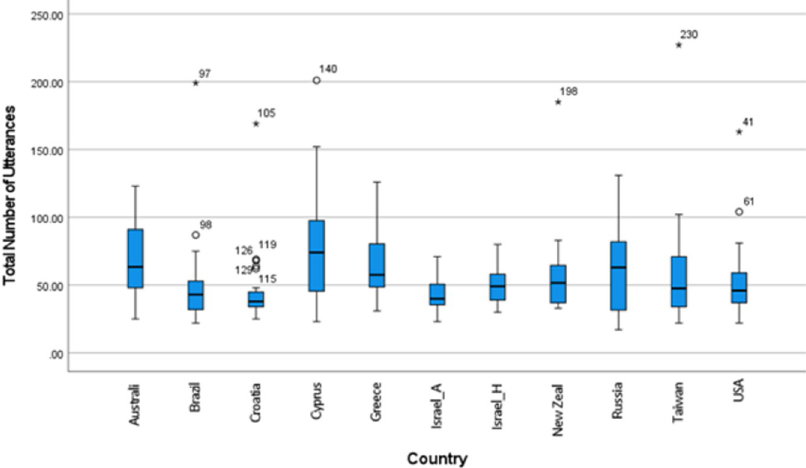
Fig 1. Total number of utterances by country. Indicates an outlier (more than 1 standard deviation [SD] from the mean; � outlier > 2 SD from the mean; numbers refer to individual case numbers in SPSS.